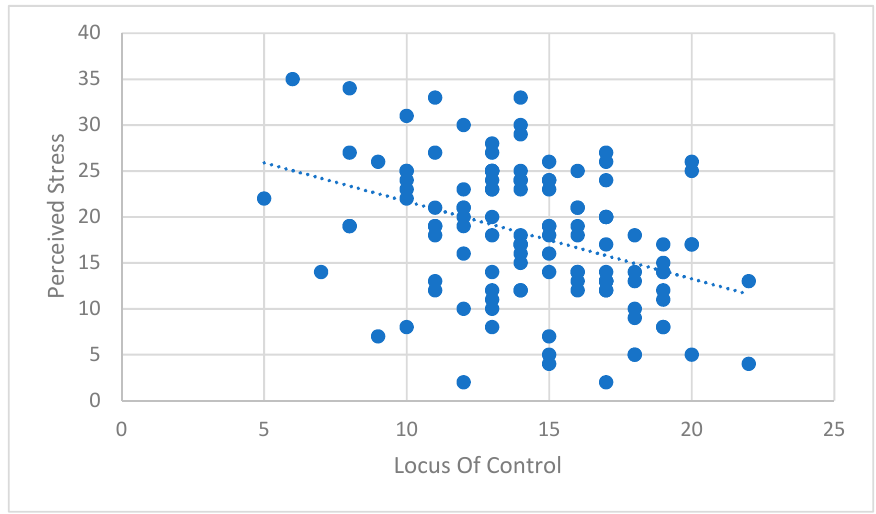
Figure 1. Scatter plot of perceived stress and locus of control.